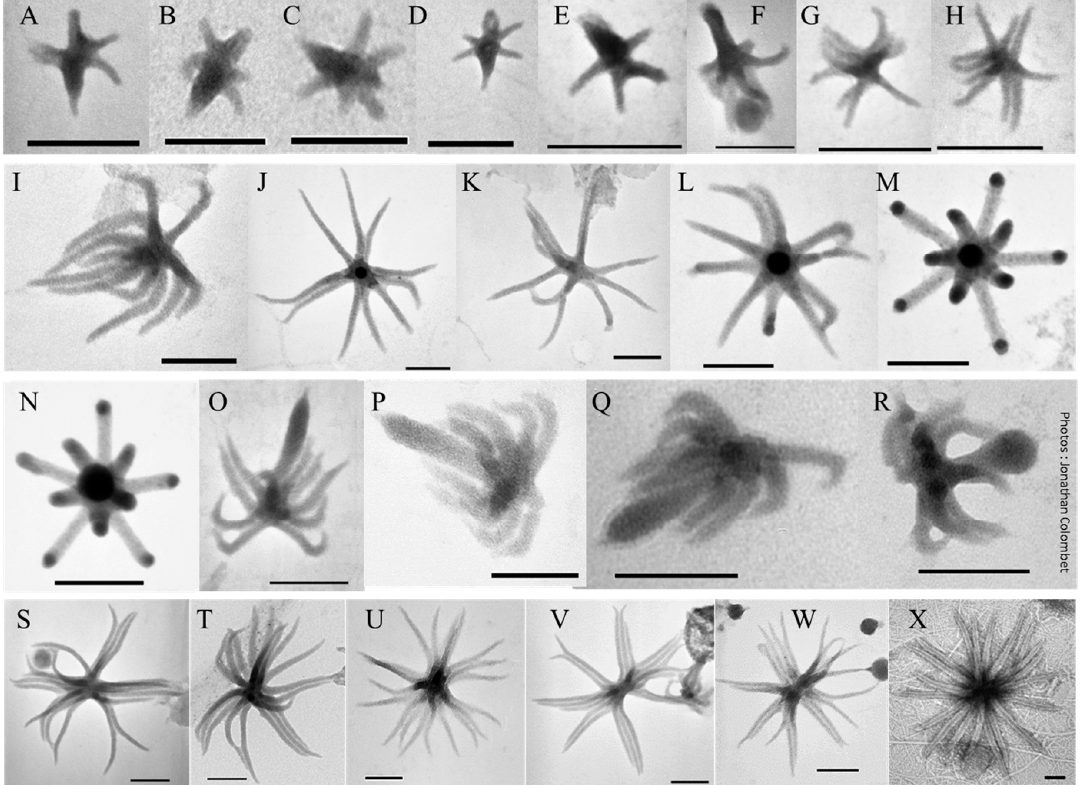
Figure 5. Transmission electron micrographs of di ff erent morphotypes of aster-like nanoparticles (ALNs). ( A – H ) 4–10-armed forms. ( I – M ) 11-armed forms and their budding 11-armed variants ( N – R ) with elongated and swollen bud-like excrescences. ( S – X ) 20-armed forms. Scale bars = 100